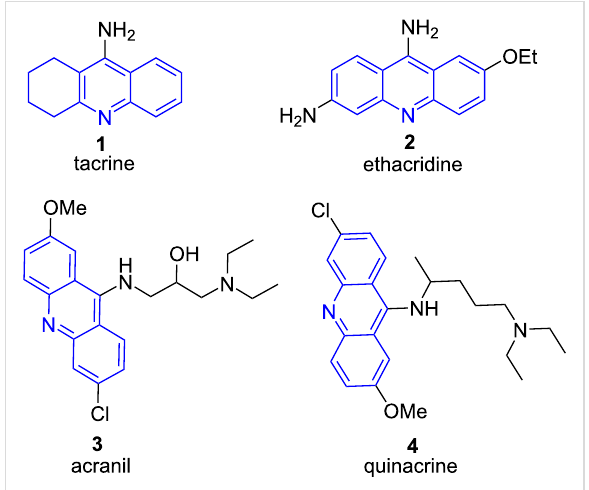
Figure 1: Marketed drugs with acridine moiety.